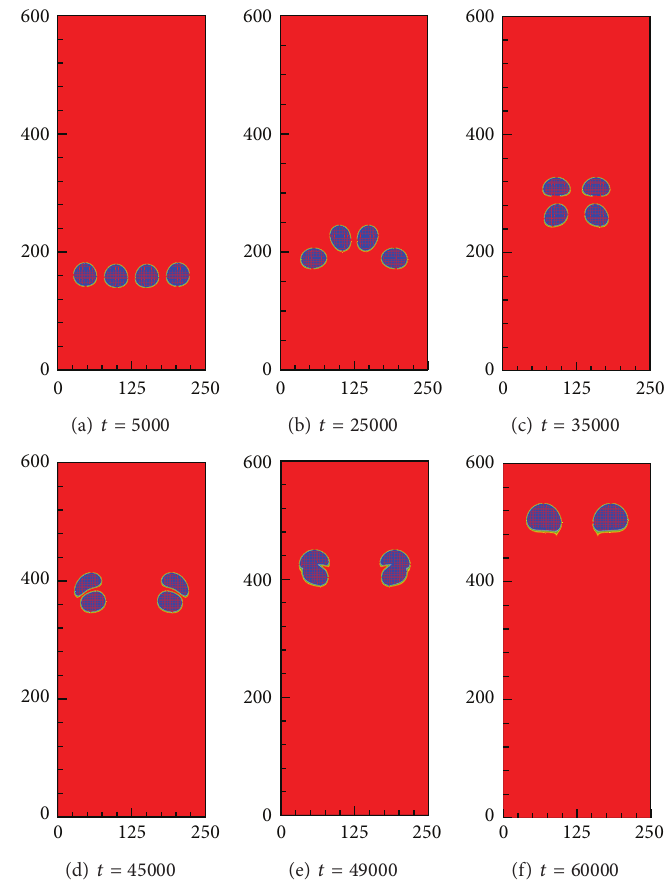
Figure 11: The contour of order parameter of four bubbles for Eo = 50